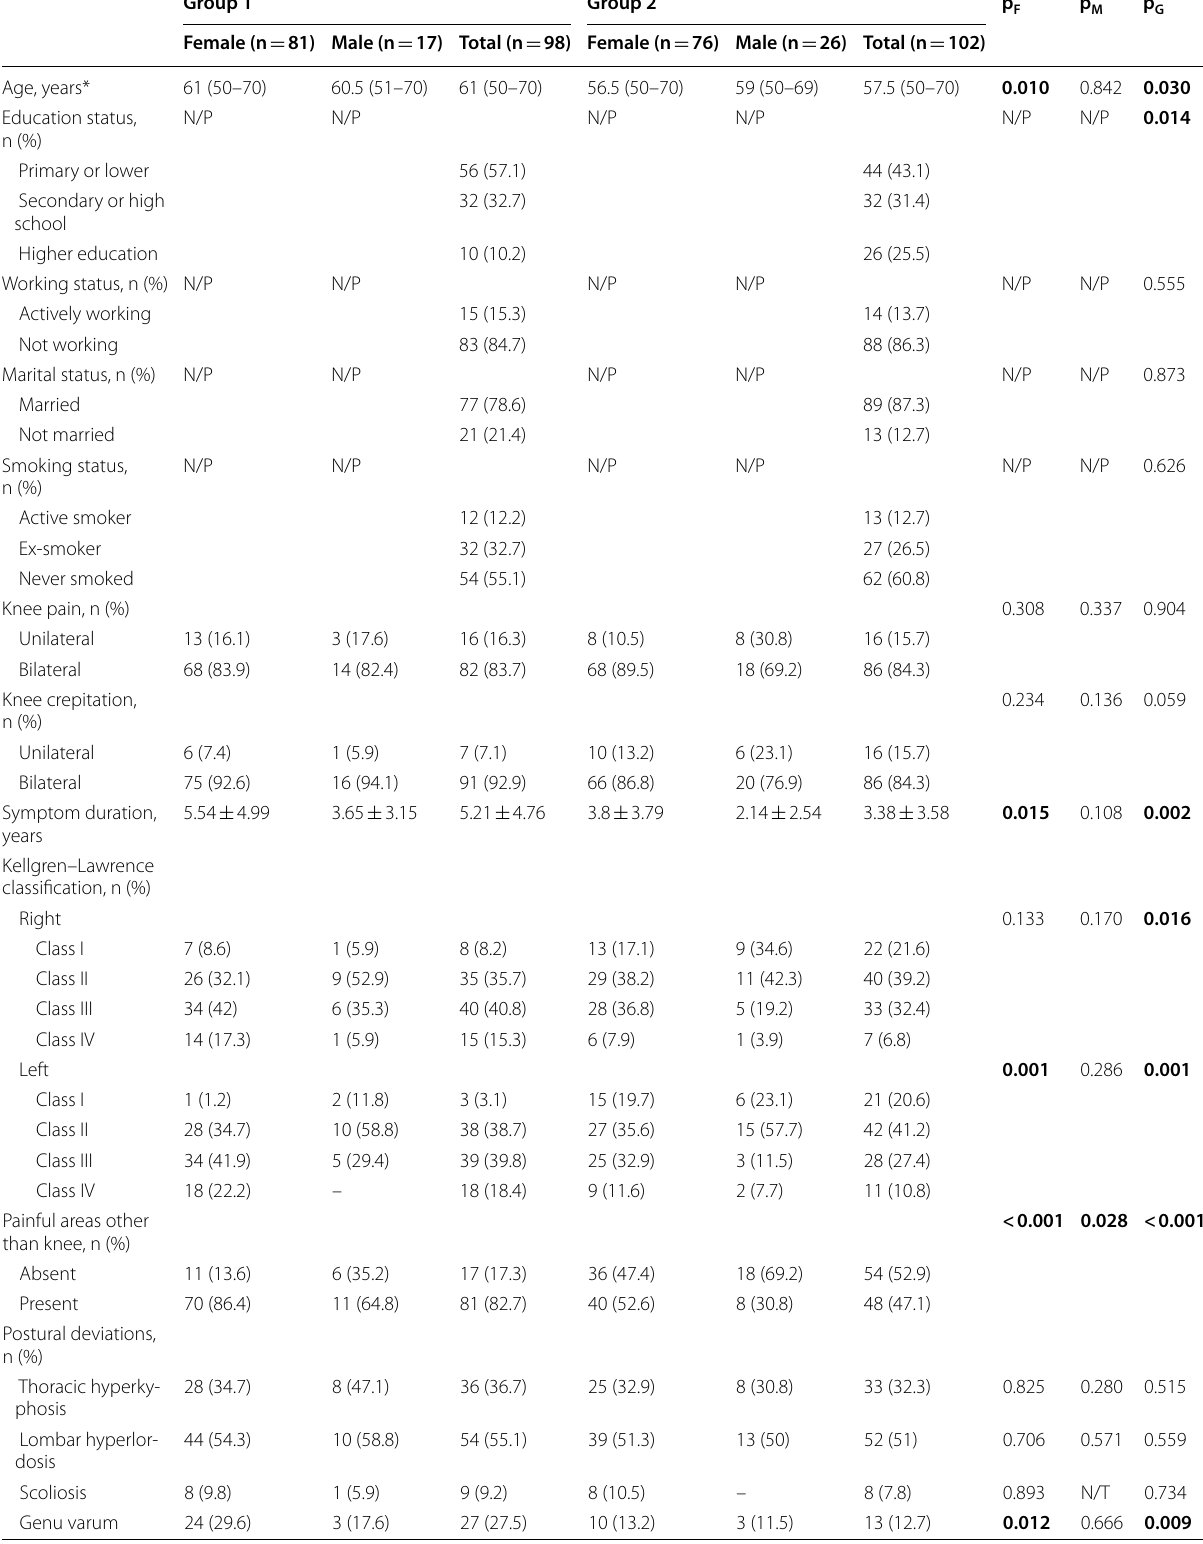
Table 1 Demographic, clinical, and radiological features of the study groups Group 1 Group